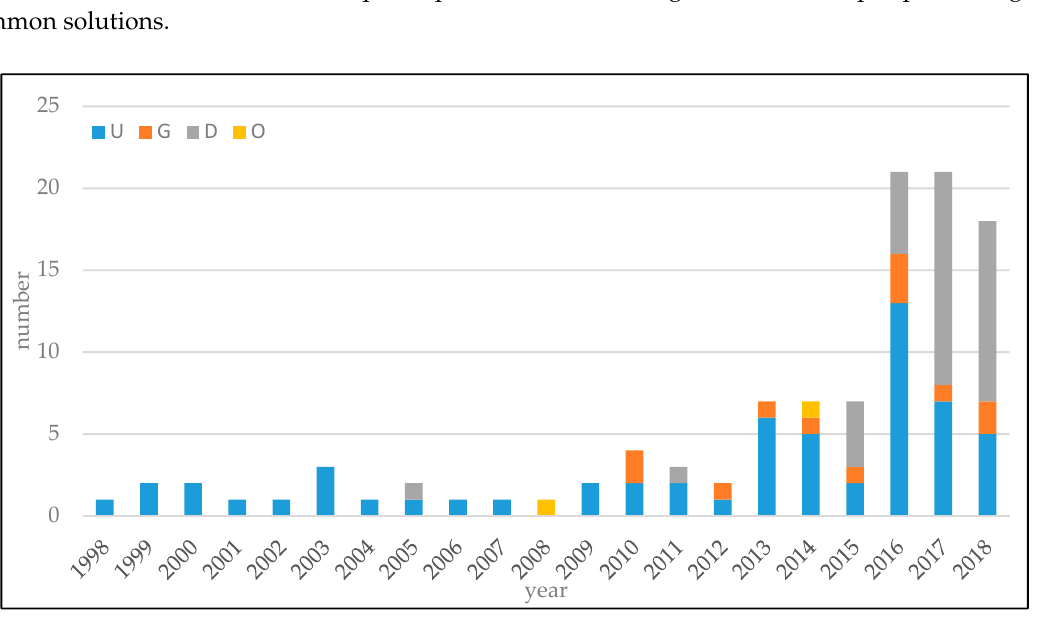
Figure 9. Trends of the technology used in this field. For the convenience of observation, the 3D feature methods merge into others.